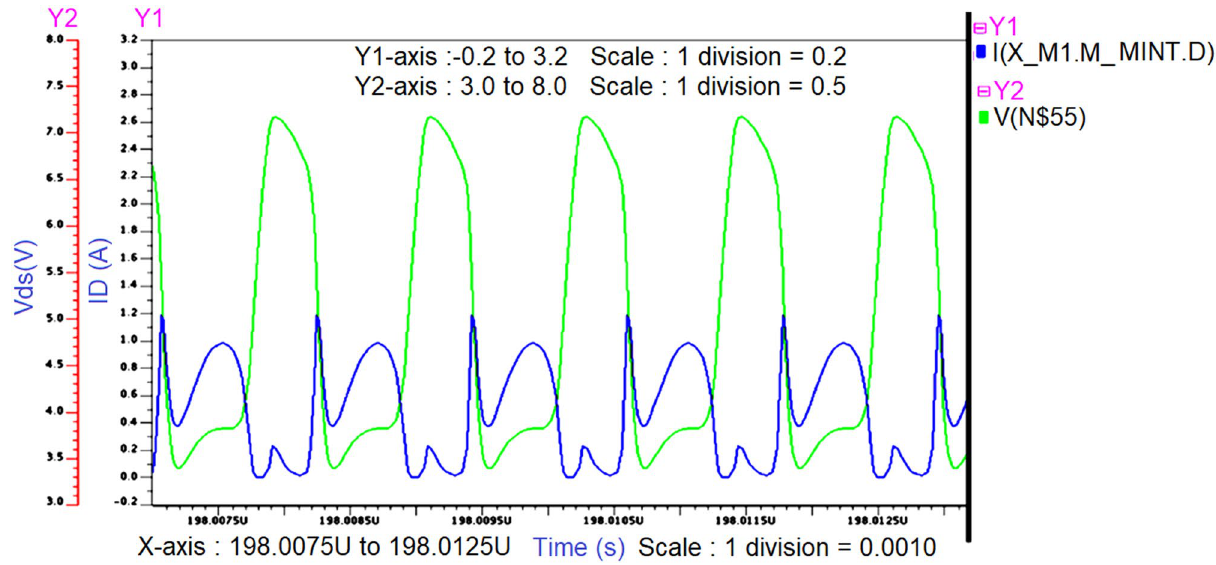
Figure 12. Intrinsic voltage and current waveforms at the drain of Class-J PA (V DS and I D ) with Fourier input source at 850 MHz.